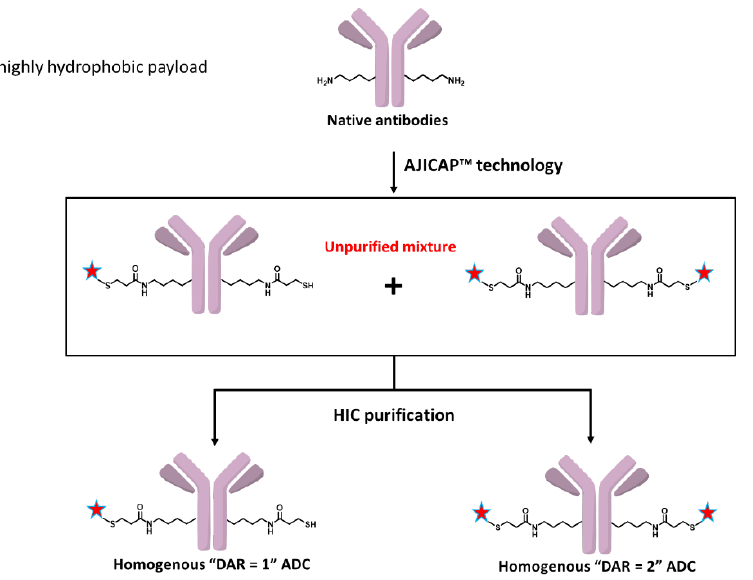
Figure 2. Overview of site-specific conjugation/HIC purification strategy.